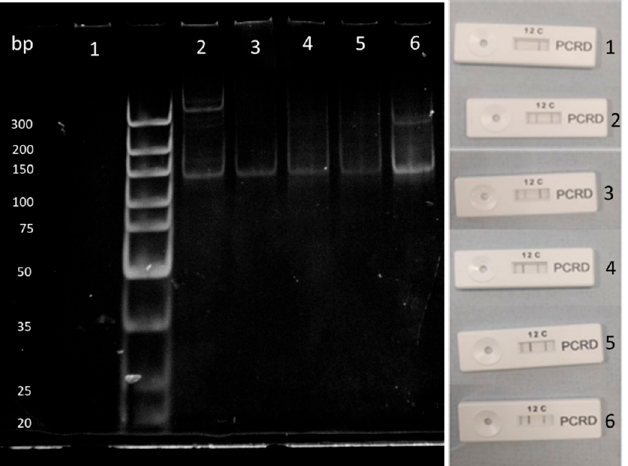
Figure 7. Dilution factors for template DNA of B. subtilis from 0 ng / µ L (1) to 10 ng / µ L (6) compared between lateral flow and polyacrylamide gel. Line (1) indicates the amplified B. subtilis gene whilst line (2) indicates amplified E. coli gene. Line (C) is the control line.